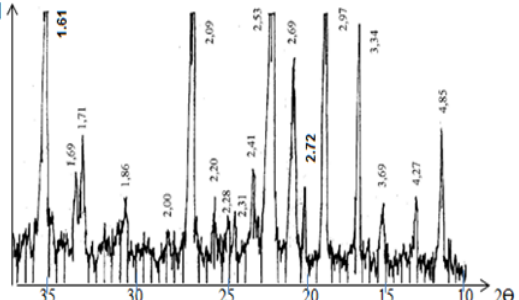
Fig. 5. X-ray diffractogram of Uvgundatsan iron ore